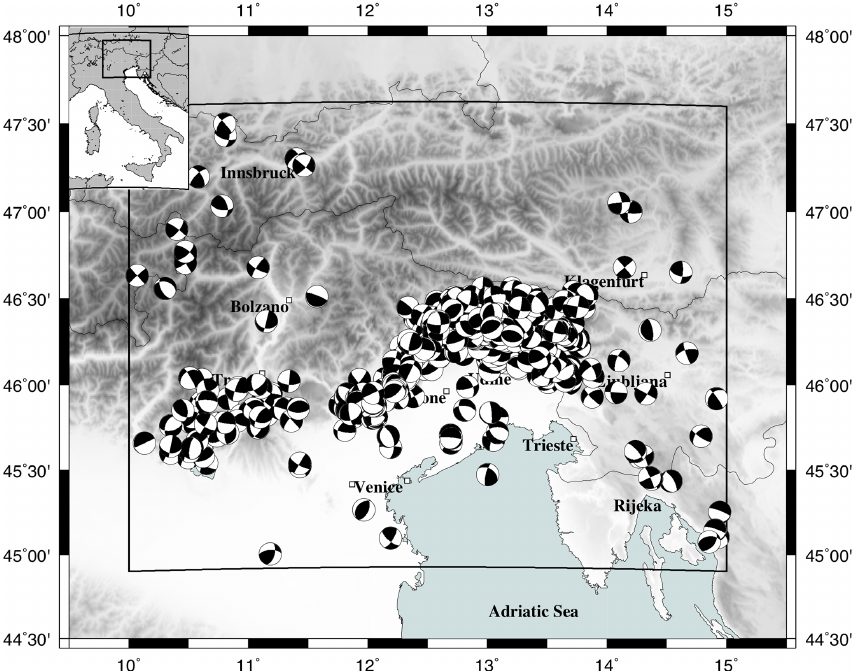
Figure 2. Overview of the focal mechanisms contained in our catalogue. The map was generated by GMT software (Wessel et al.,